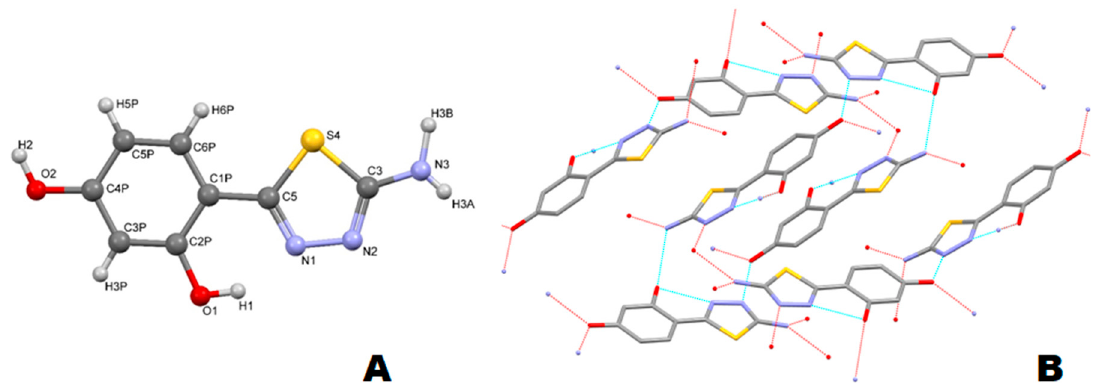
Figure 3. Crystal structure of thiadiazole 1 . ( A ) Atoms are numbered according to the cif file (see supplementary material); ( B ) Packing of the molecules in a crystal net (for better clarity, the hydrogen atoms are omitted).